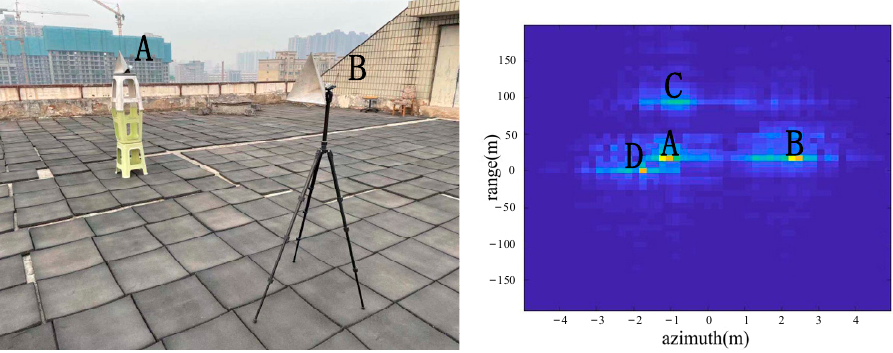
Figure 16. The 11th group of experimental scenes and imaging results. According to the simulation parameters in Table 1, the Rayleigh diffraction limit resolution was calculated to be 29.4449 m. In this experimental scenario, the